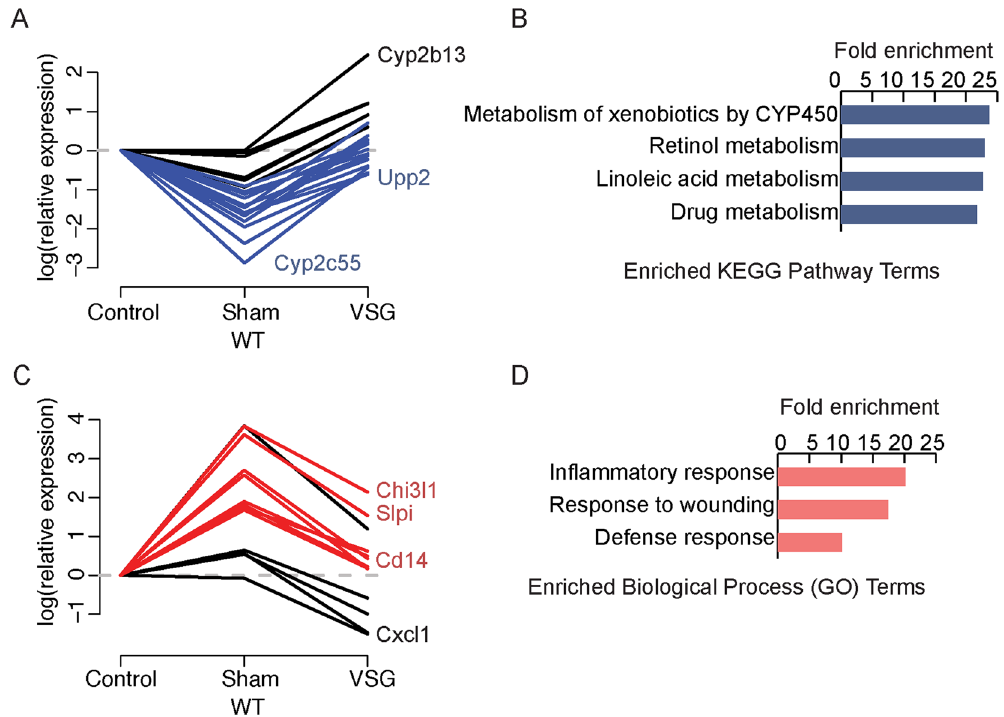
Figure 3. Inflammatory and lipid metabolic genes are altered in mouse liver after VSG. ( A ) Line plot of relative gene expression for genes up-regulated in VSG compared to Sham mice. ( B ) Enriched KEGG Pathway terms for genes up-regulated in VSG compared to Sham mice. ( C ) Line plot of relative gene expression for genes down- regulated in VSG compared to Sham mice. ( D ) Enriched Gene Ontology Biological Process terms for genes down-regulated in VSG compared to Sham